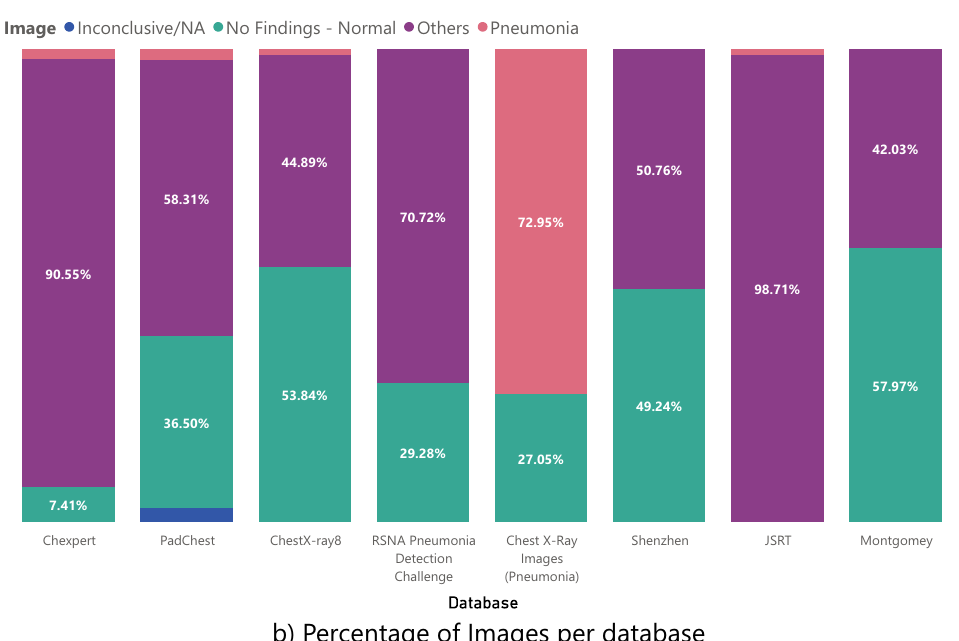
Figure 4. Number and Percentage of images according to a specific pathology on each Control